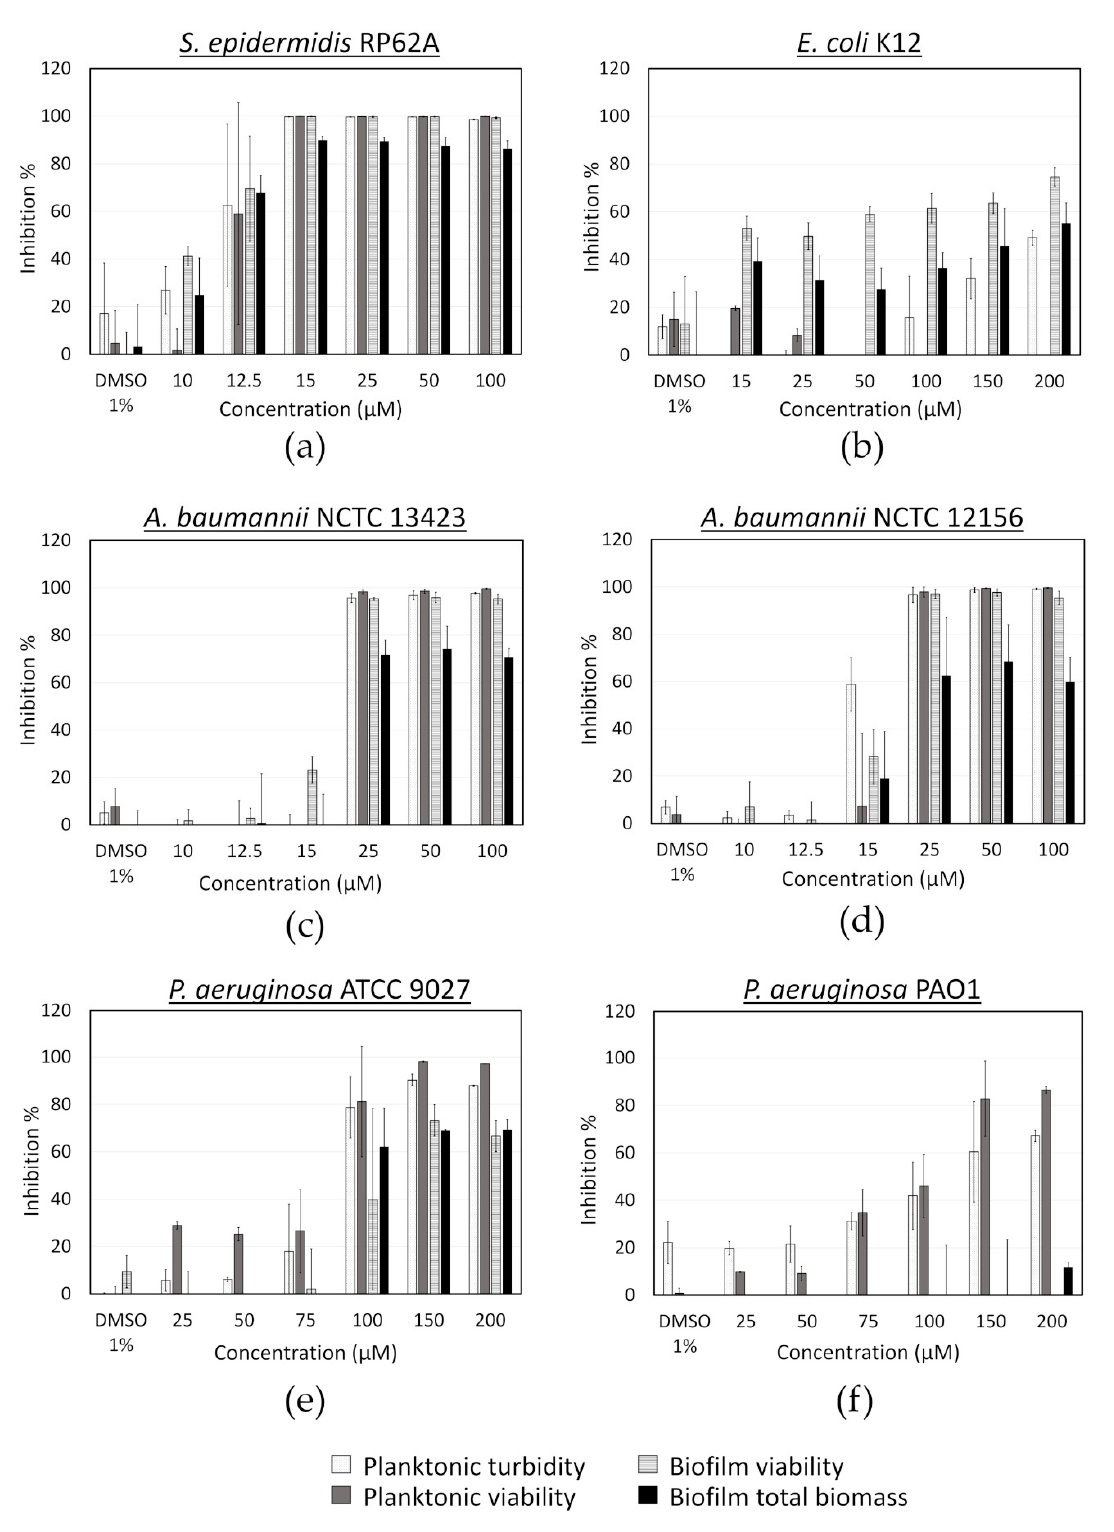
Figure 7. Activity of fingolimod against different bacterial species in the pre-exposure mode. Results are from two distinct experiments with each two or three biofilm replicates for all concentrations ± SD.